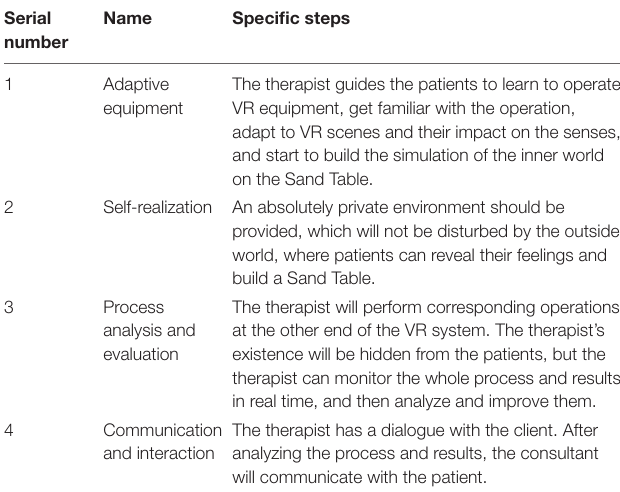
TABLE 2 | Specific steps of the treatment